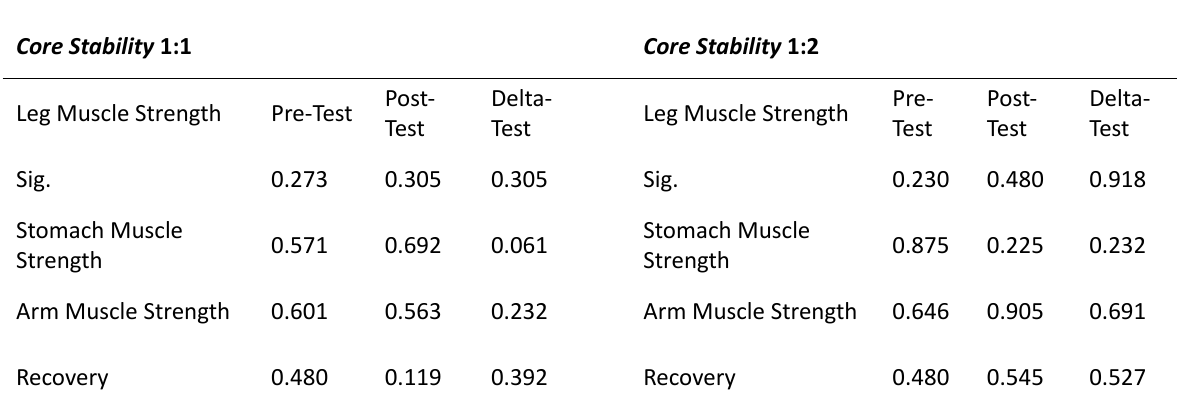
Table 1. The Result of Normality